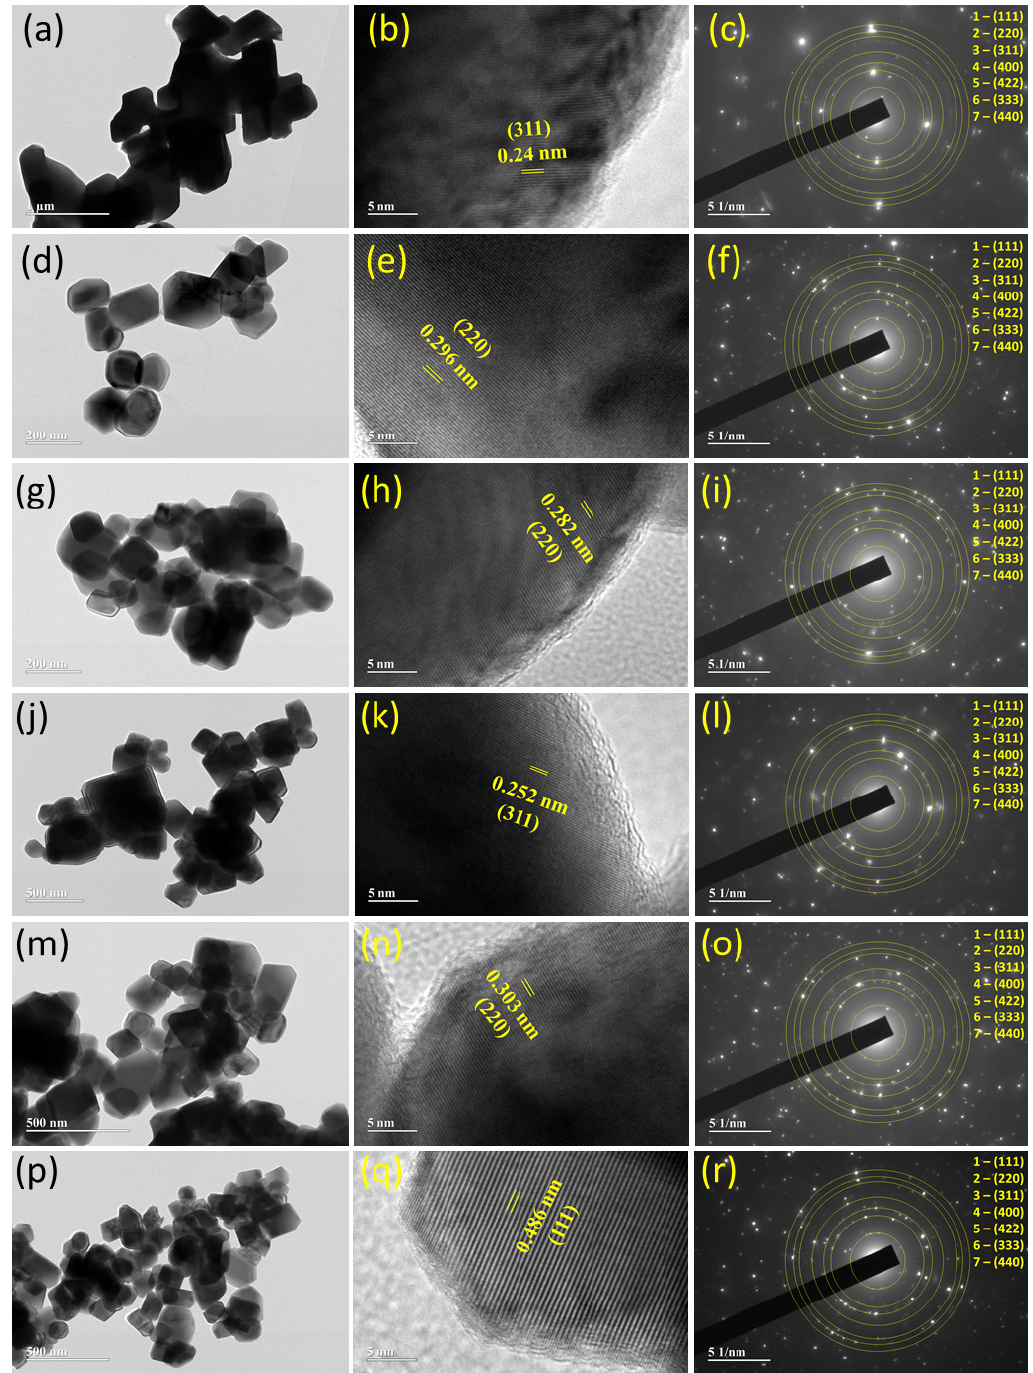
Figure 5. TEM images and selected area electron diffraction (SAED) of Mn X Co 3-X O 4 (0 ≤ X ≤ 1) samples: ( a – c ) X = 0.0, ( d – f ) X = 0.2, ( g – i ) X = 0.4, ( j – l ) X = 0.6, ( m – o ) X = 0.8, and ( p – r ) X = 1.0.